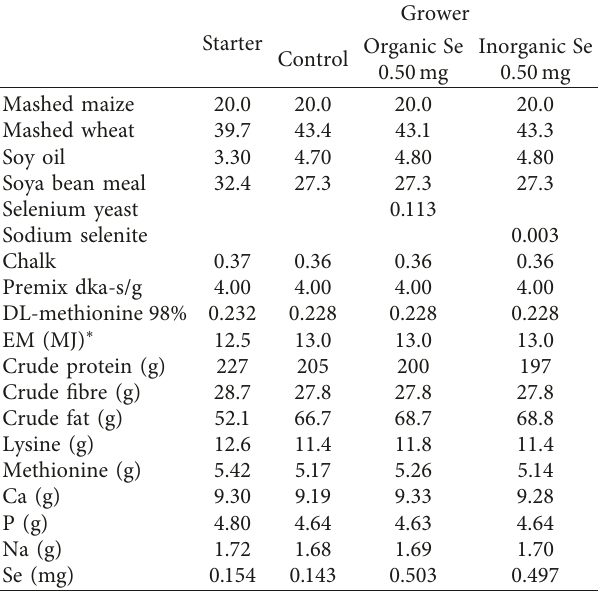
Table 1: Composition of experimental diets. Grower Starter Organic Se Inorganic Se Control 0.50mg 0.50 mg Mashed